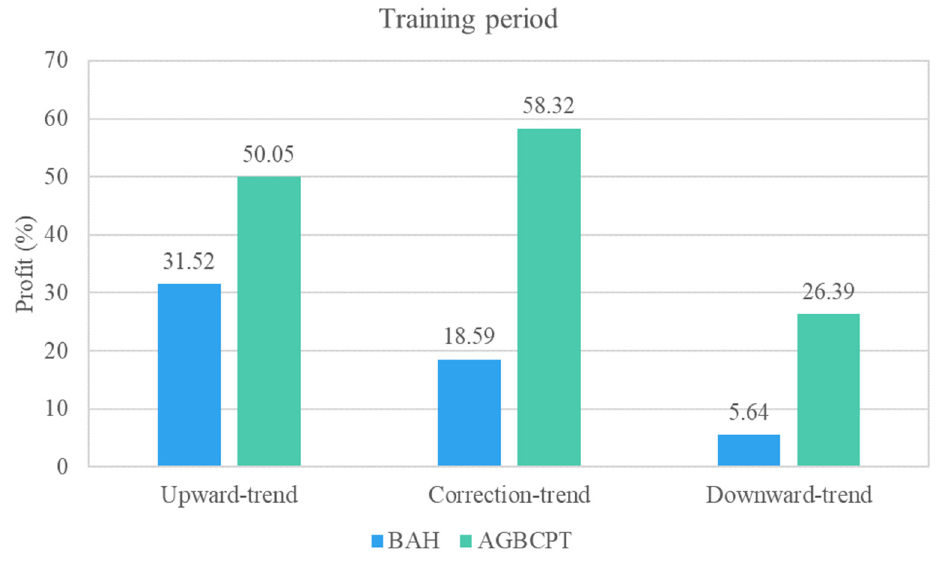
Figure 12. AGBCPT and BAH training results.